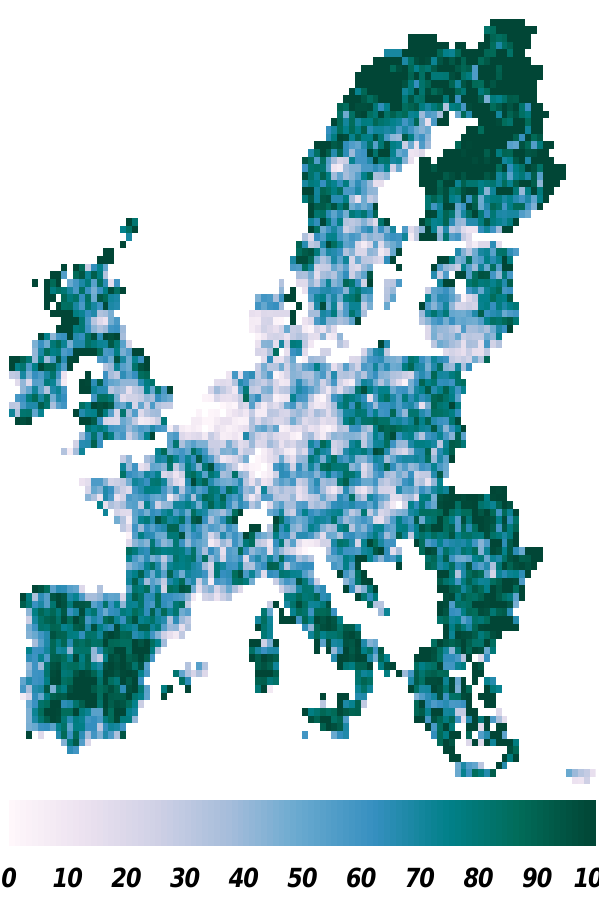
Figure 5. Local density of available street-level imagery within a 2 km radius of LUCAS 2018 points based on a systematic spatial sampling of 337,031 points averaged by grid cell